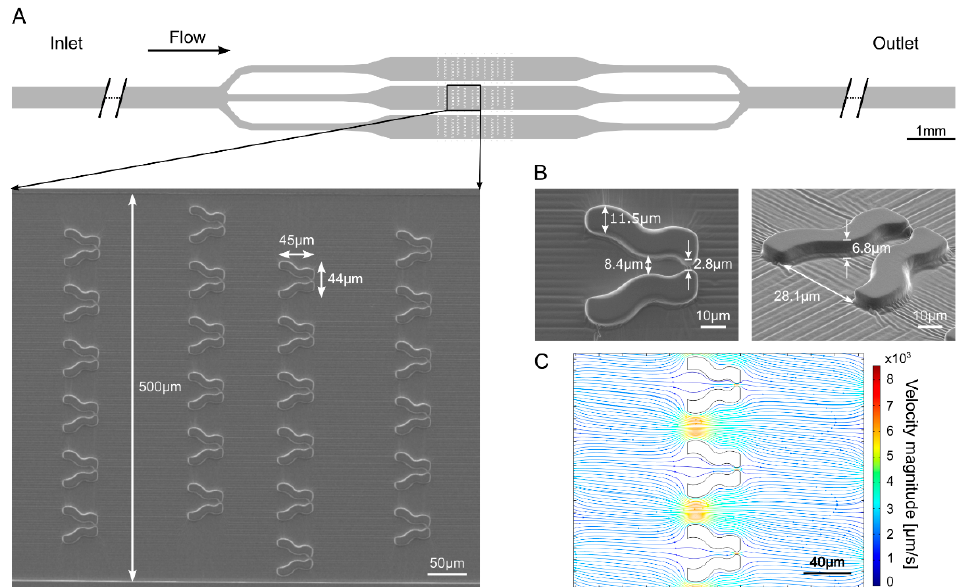
Figure 1. “Tulip” microfluidics platform for capturing and immobilizing individual C. reinhardtii cells enabling the measurement of their photosynthetic activity. ( A ) Scheme of the device and a scanning electron microscopy image taken in a region of the schematic view. The direction of the flow is indicated by the arrow. ( B ) Scanning electron microscopy images of single “Tulip” traps in the microfluidic device. ( C ) Computational modeling of the flow in the device. The density of the streamlines and the color code represent the velocity magnitude.